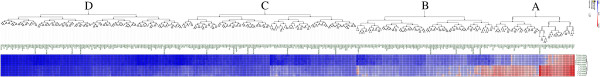
Dendrogram used for clustering analysis of the common upregulated differentially expressed genes. As shown in the diagram, the genes are divided into four categories (A, B, C and D).